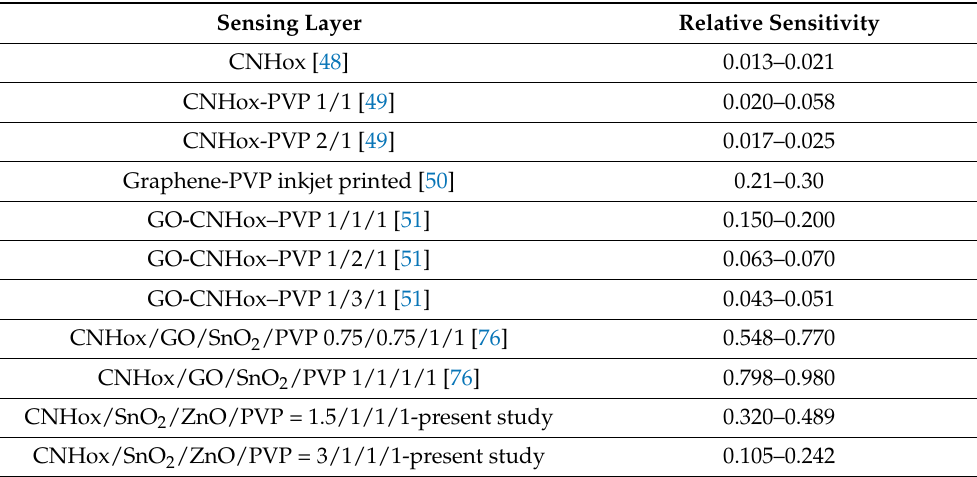
Table 1. Sensitivity CNHox–SnO 2 -ZnO–PVP compared with previous tested sensing